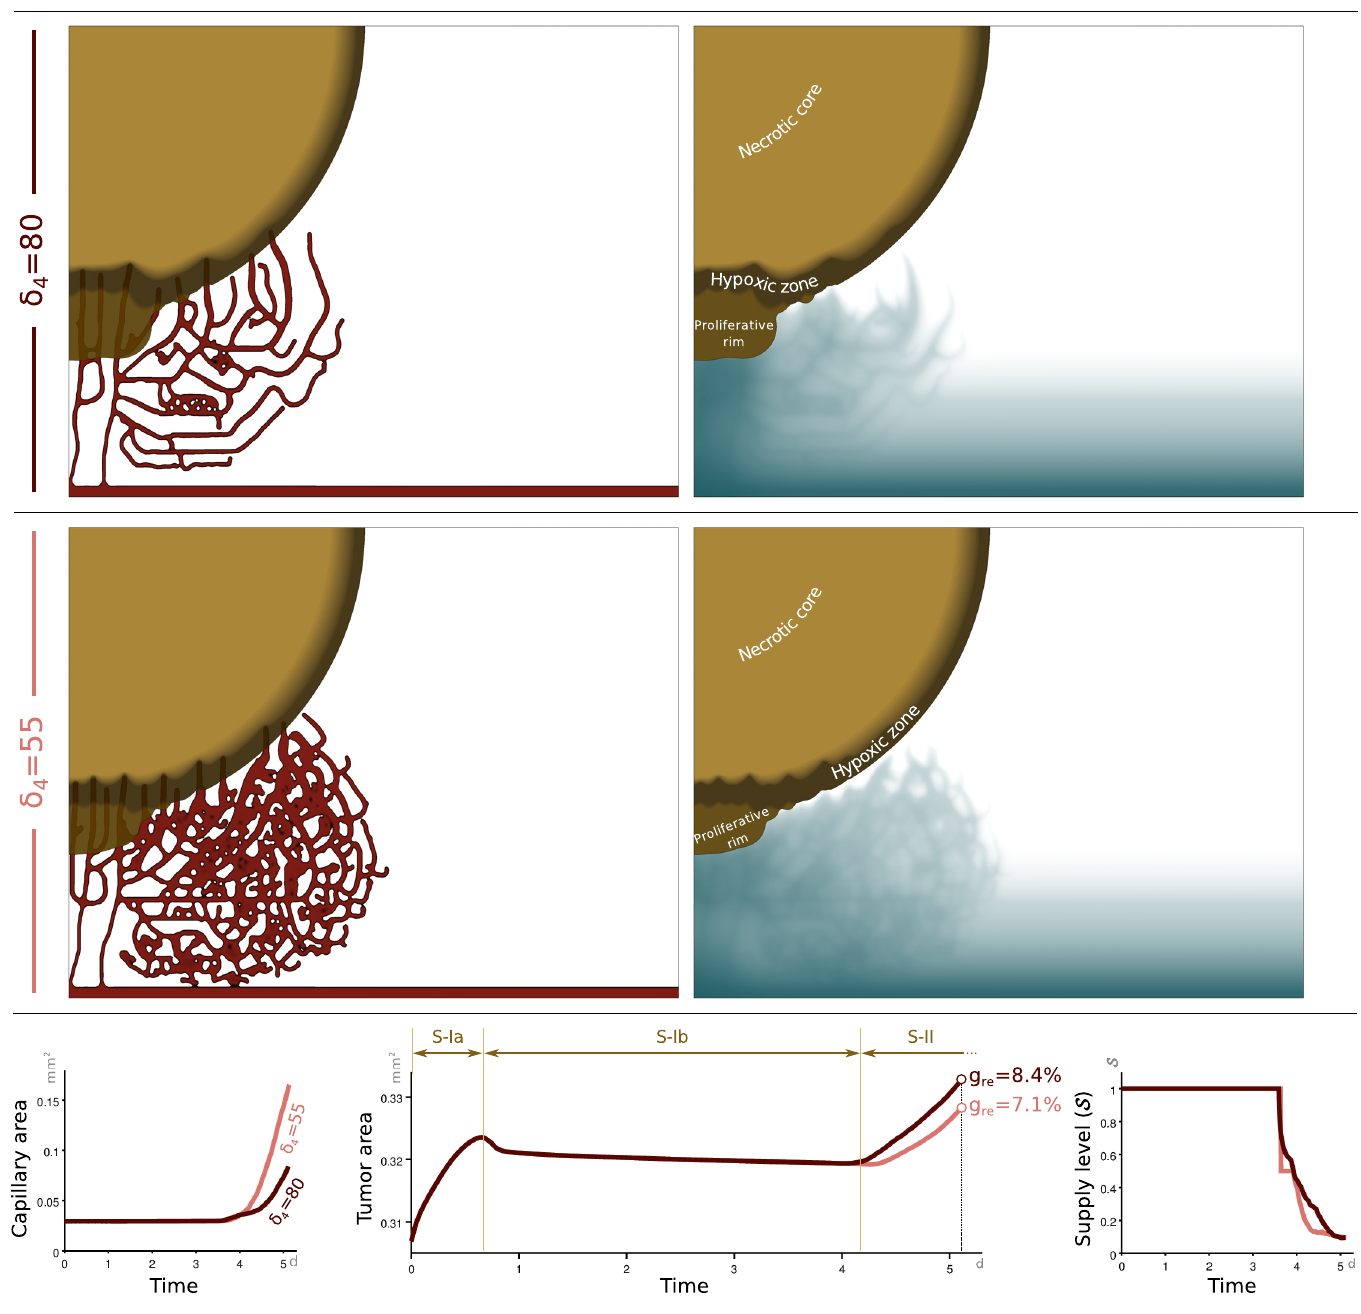
Fig 7. Simulation of tumor-growth reduction by blocking Dll4. The simulation in the top row shows snapshots of the tumor (brown scale), capillaries (red), and nutrient concentration (blue scale) for a typical value of the effective Dll4 distance, namely δ 4 = 80. Note that on the right hand side panels we removed the capillaries to allow for a clearer observation of the nutrient distribution. The mid row shows the results of an analogous simulation in which the effective Dll4 distance has been reduced to δ 4 = 55 to simulate the negative regulation of the Dll4 signaling pathway. As expected, the simulation shows a denser vascular network. The bottom left panel quantitatively illustrates this point. The denser vascular network, however, does not lead to faster tumor growth, but the opposite (see the bottom central panel). This phenomenon has been observed experimentally and is a consequence of the reduced transport functionality of the vascular network. In our model, the transport capacity is measured by the quantity S [see Eq (7)], whose time evolution is shown in the bottom right